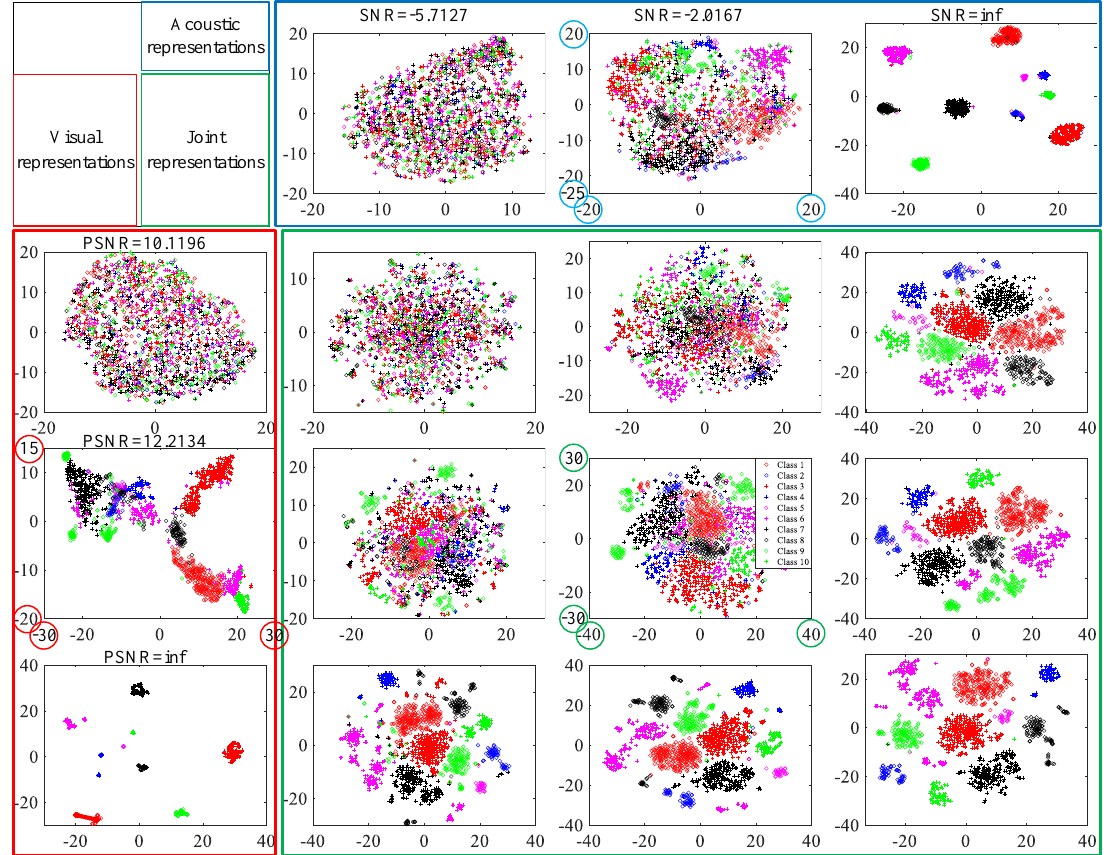
Figure 9. Representations of single-modality and joint representations of